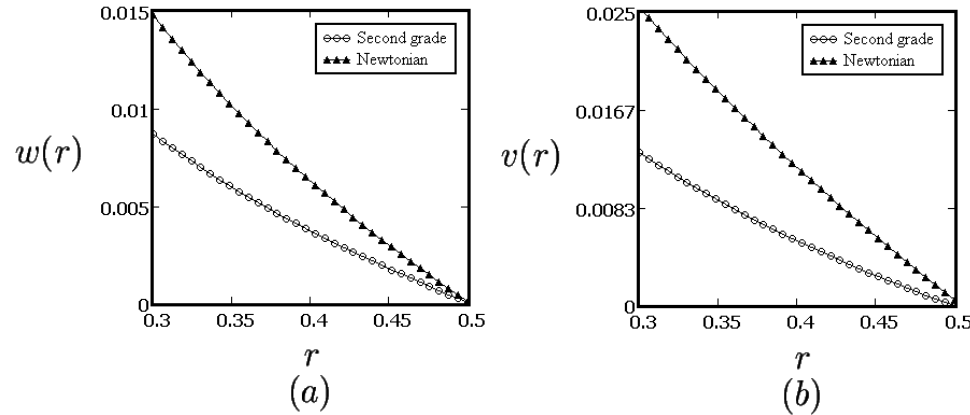
Fig. 9. Profiles of the velocity components w ( r , t ) and v ( r , t ) for second grade and Newtonian fluids, given by Eqs. (39), (64) and (65), for